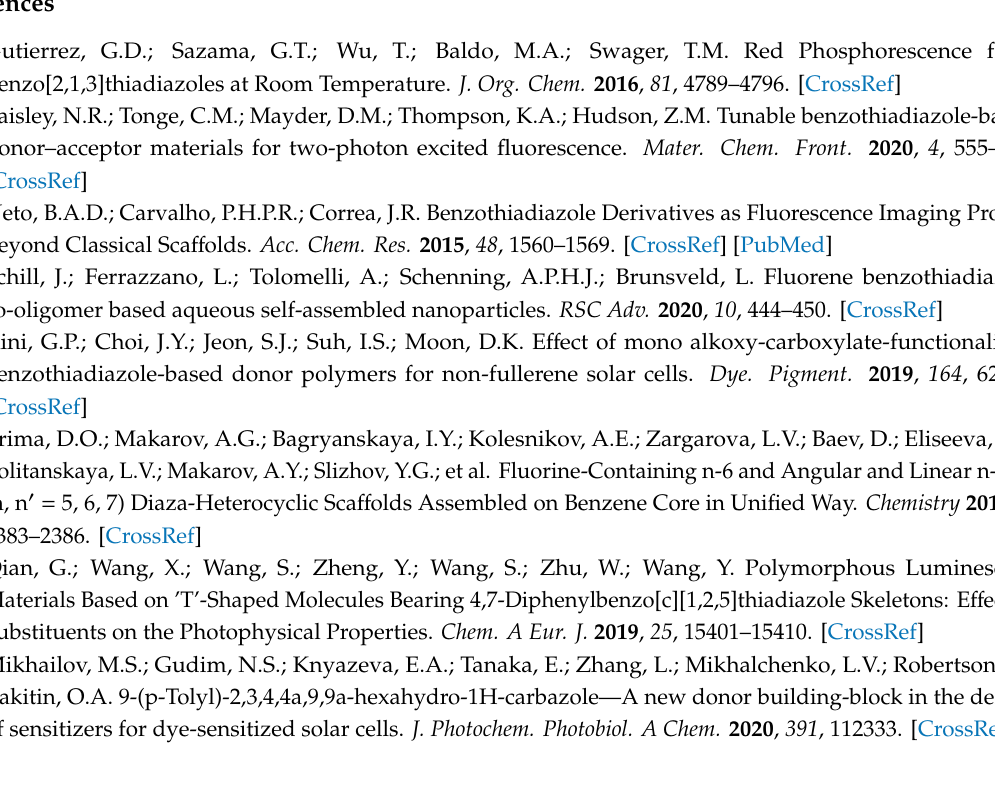
Supplementary Materials: The following are available online: Figure S1: Experimental and simulated powder patterns of the compounds 2a · 3C 7 H 8 and 2b · 2.5C 7 H 8 ; Figure S2: Representation of selected torsion angles in H 2 L (cid:48) or L 2– fragments; Figure S3: Molecular structure of 1 showing attraction interaction Zn–N 4 ; Figure S4: The d norm Hirshfeld surface of the complexes in crystal structures 2a · 3C 7 H 8 and 2b · 2.5C 7 H 8 ; Figure S5: Representation of a Cu–H 2 L model with the geometry derived from XRD data for free H 2 L and the corresponding fragment from XRD data for 3 ; Figure S6: Overlaid TD-DFT calculations results and experimental UV-vis spectrum of H 2 L; Table S1: Calculated properties of the first singlet excited states S 0 → S n of H 2 L; Table S2: Calculated properties of the first singlet excited states S 0 → S n of 1 ; Table S3: Calculated properties of the first singlet excited states S 0 → S n of 2b ; Table S4: Crystal data and structure refinement for H 2 L 1 – 4 ; Figure S7: Frontier molecular orbitals of 1